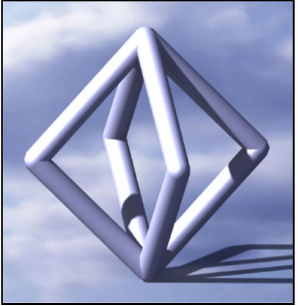
Figure 1. Octahedron at the first scale; the “cell”.